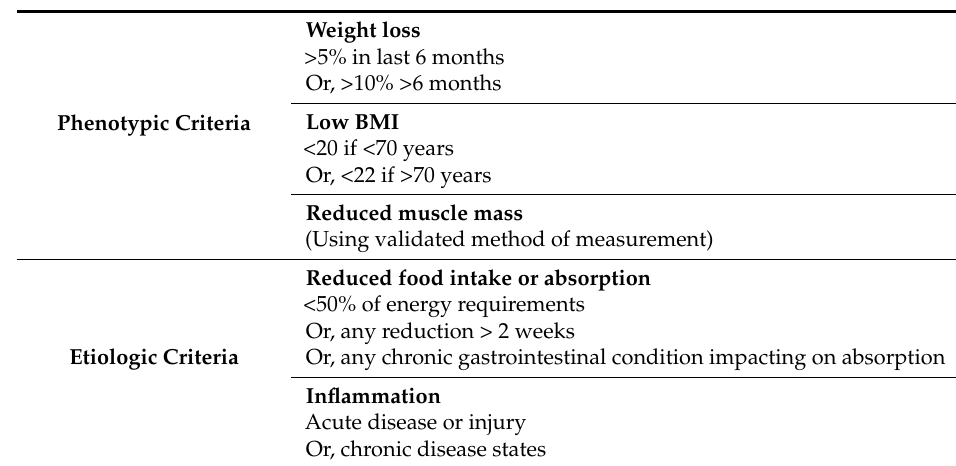
Table 1. Criteria for diagnosis of malnutrition. Diagnosis requires presence of one phenotypic and one aetiologic criteria [32]. BMI = body mass index.